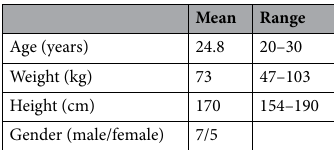
Table 1. Descriptive statistics of participants.